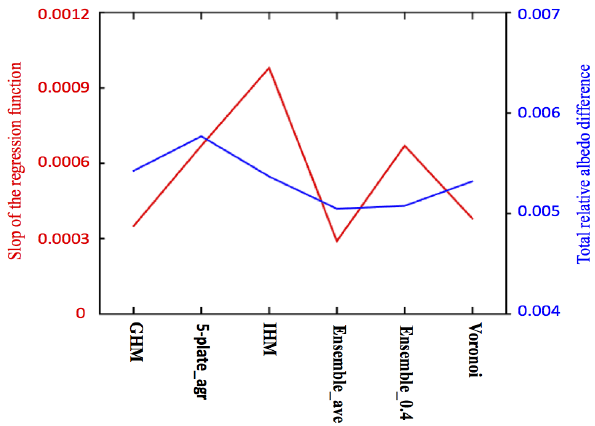
Figure 10. The slope of the regression function and total relative albedo difference for various ice particle models in Fig.